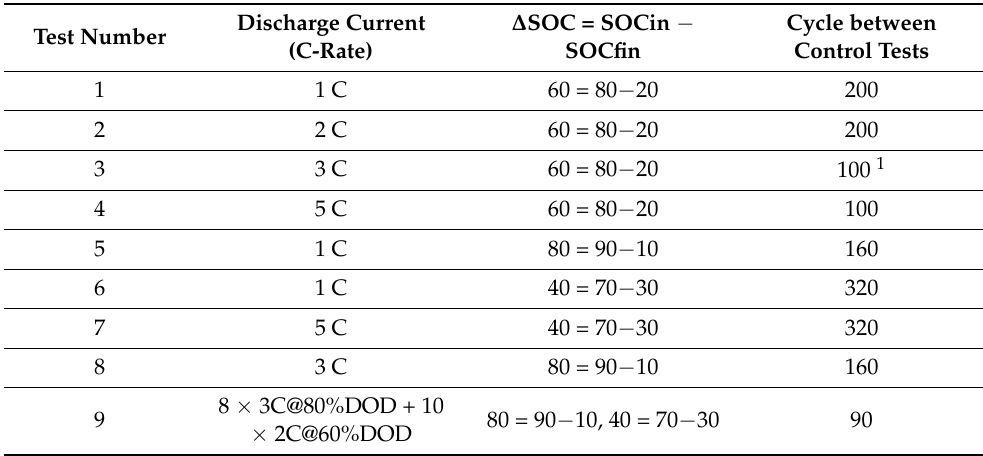
Table 3. Summary of the test parameters for the